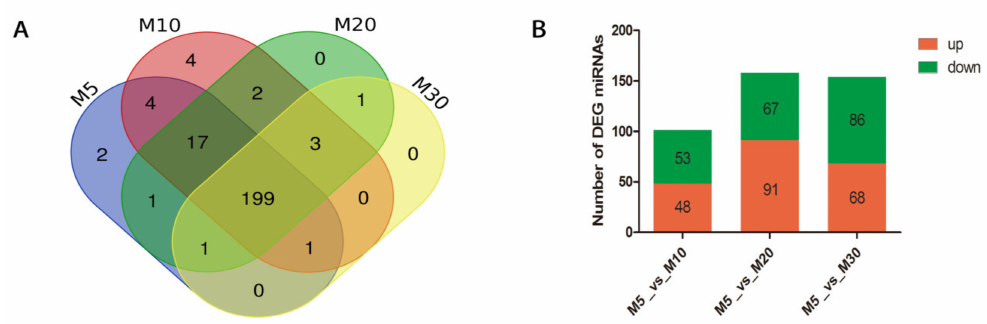
Figure 2. Comparison of the expression of miRNAs in the four libraries. ( A ). The numbers of miRNAs expressing in each of the library. ( B ). Di ff erentially expressed miRNAs during seed development. M5 library was as a